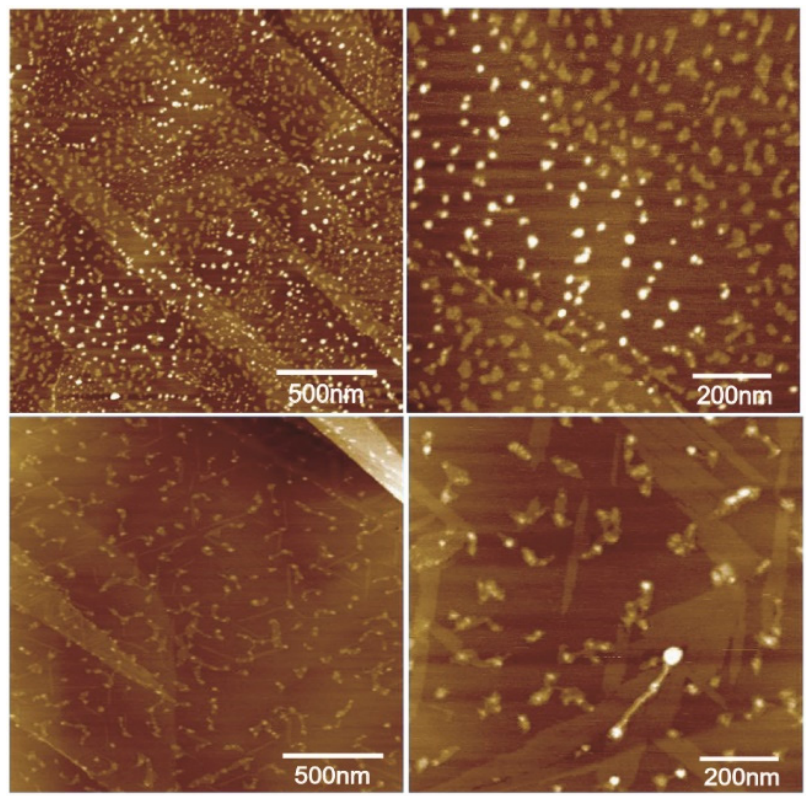
Figure 3. Atomic force images of tau aggregates. Upper panel, phase images of aggregation control. Lower panel, tau aggregates treated with compound 2 : bars 500 and 200 nm, respectively.